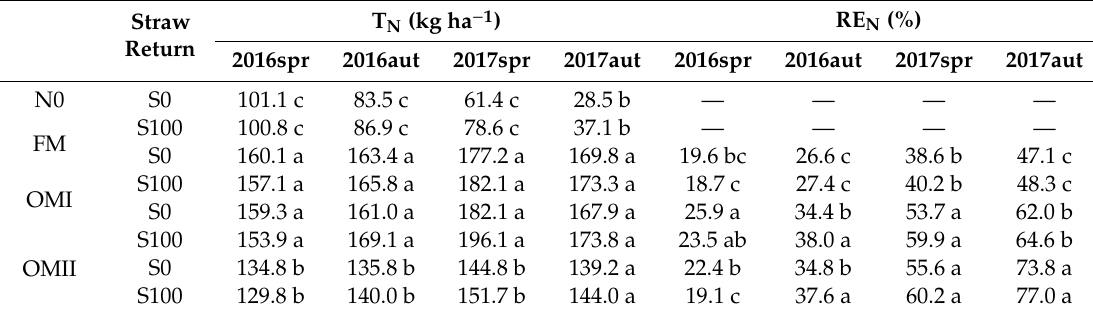
Table 7. E ff ects of N fertilizer and straw return on T N and RE N .